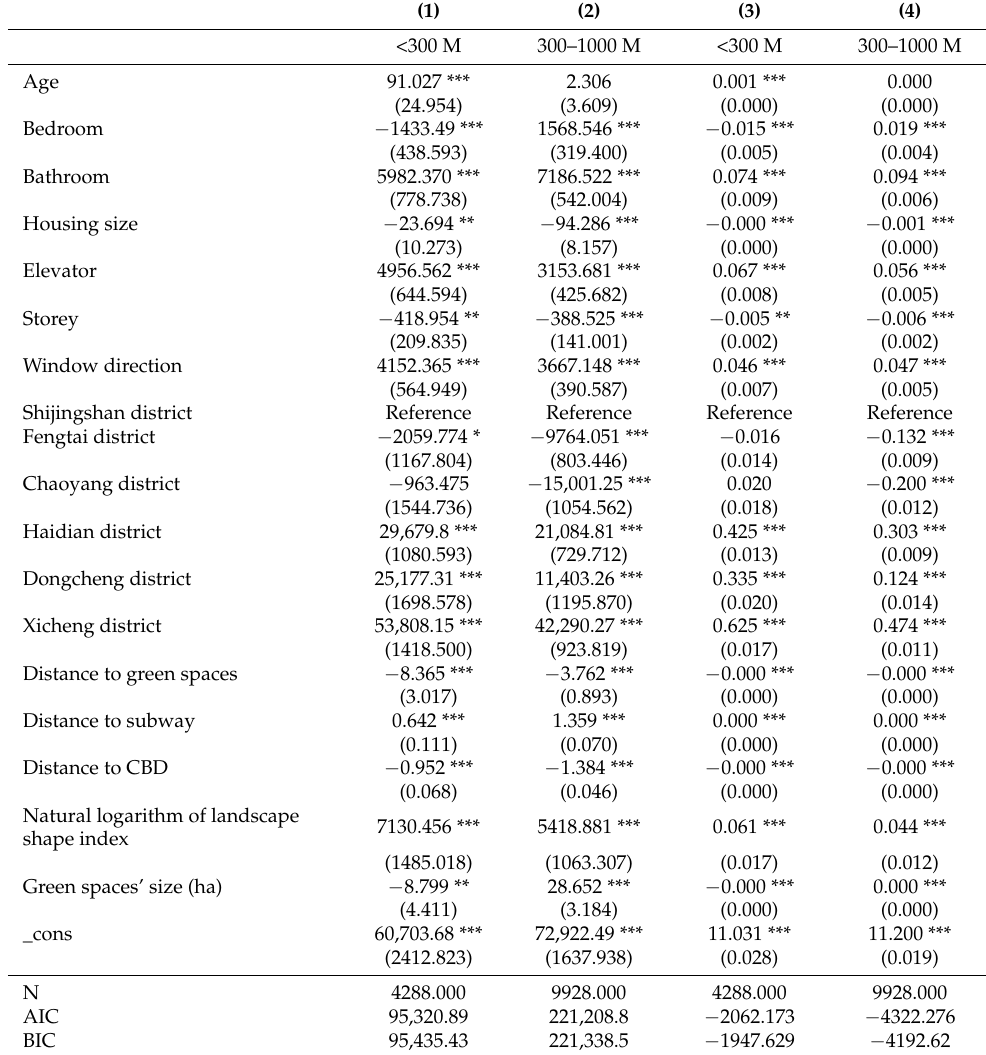
Table 3. Hedonic price model with different distance intervals from residence to green